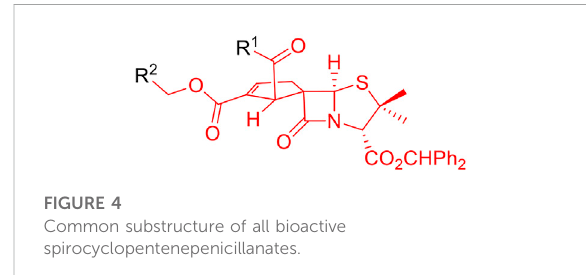
FIGURE 4 Common substructure of all bioactive